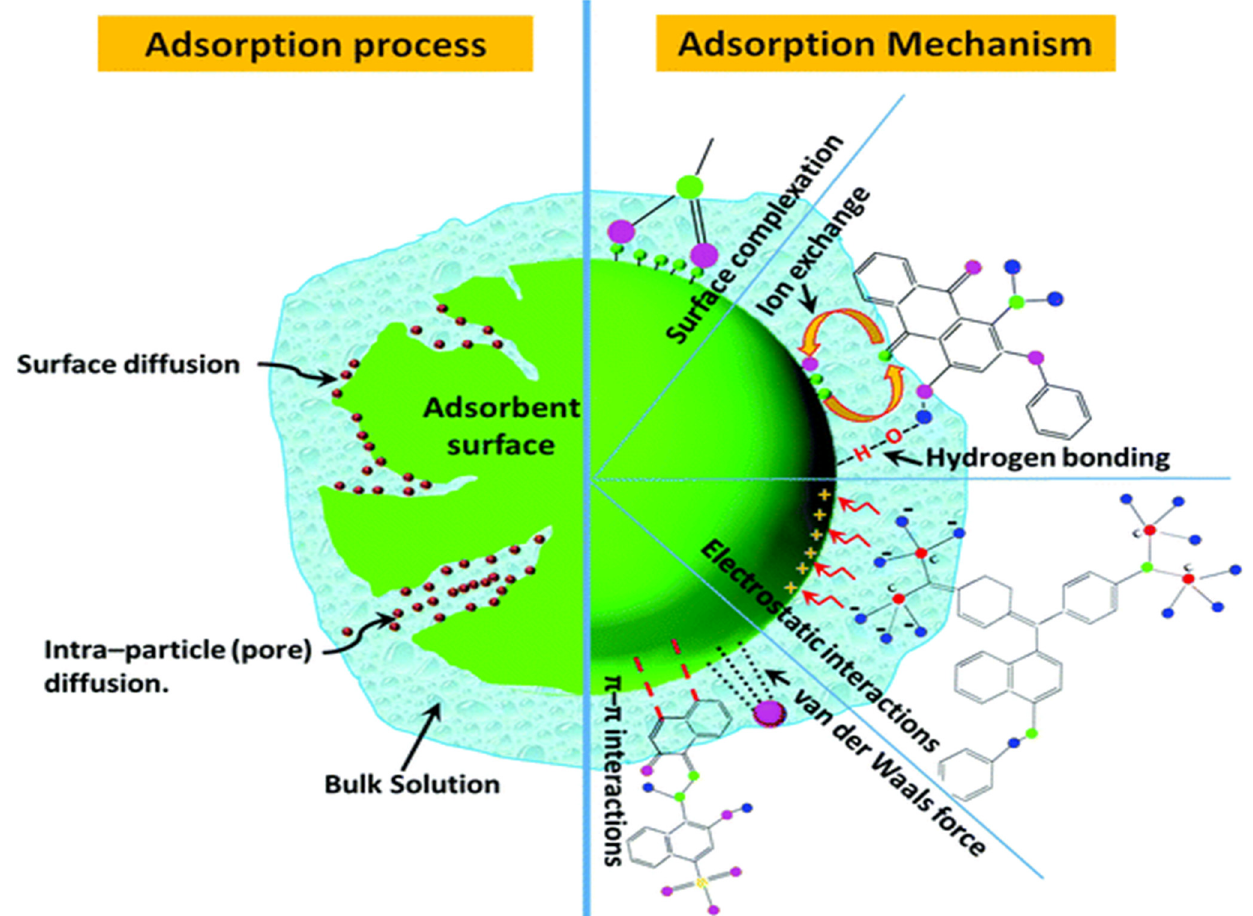
Figure 3. Adsorption process and mechanism for dye removal from wastewater